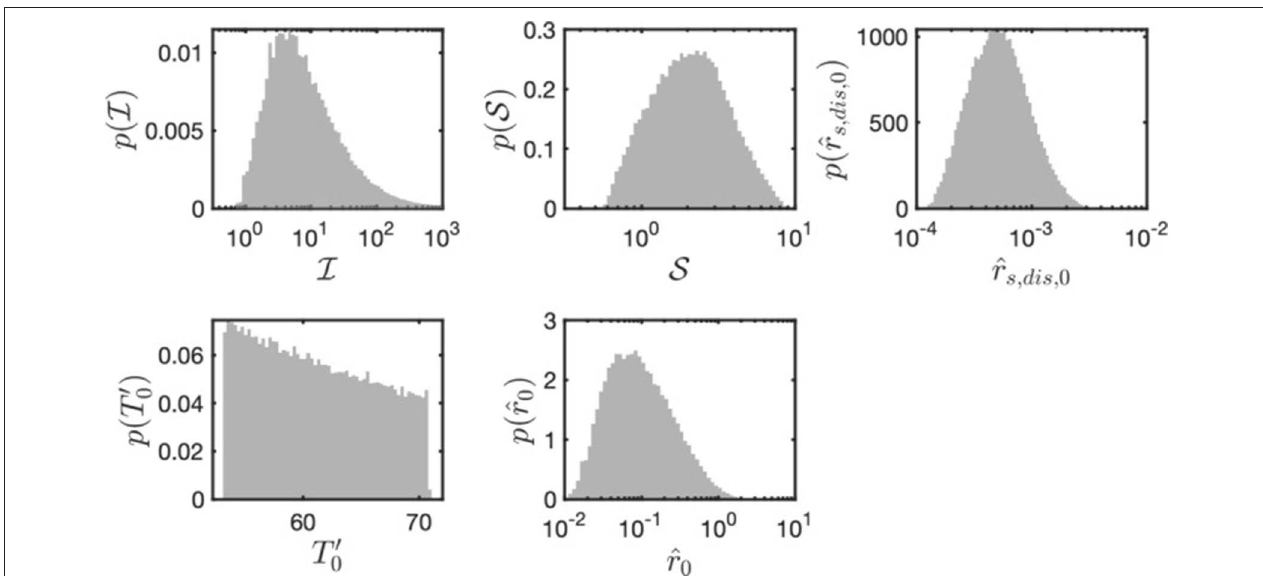
FIGURE 3 | Probability density functions of the parameter ranges of the nondimensional numbers S , I ,